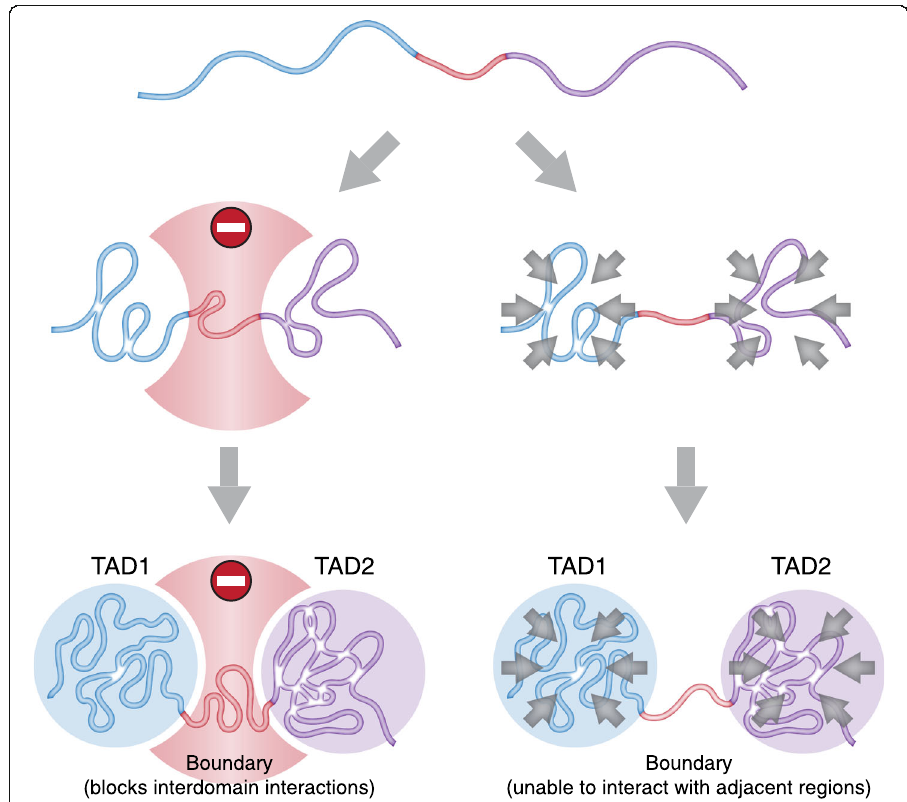
Fig. 3 A scheme illustrating two proposal mechanisms of TAD boundary action. Left panel : boundary plays an active role in TAD demarcation preventing interdomain interactions. Right panel : boundary represents a genomic region unable to fold into higher-order structures and/or to interact with adjacent regions. In contrast, TAD is comprised of chromatin regions which tend to interact with each other forming globular